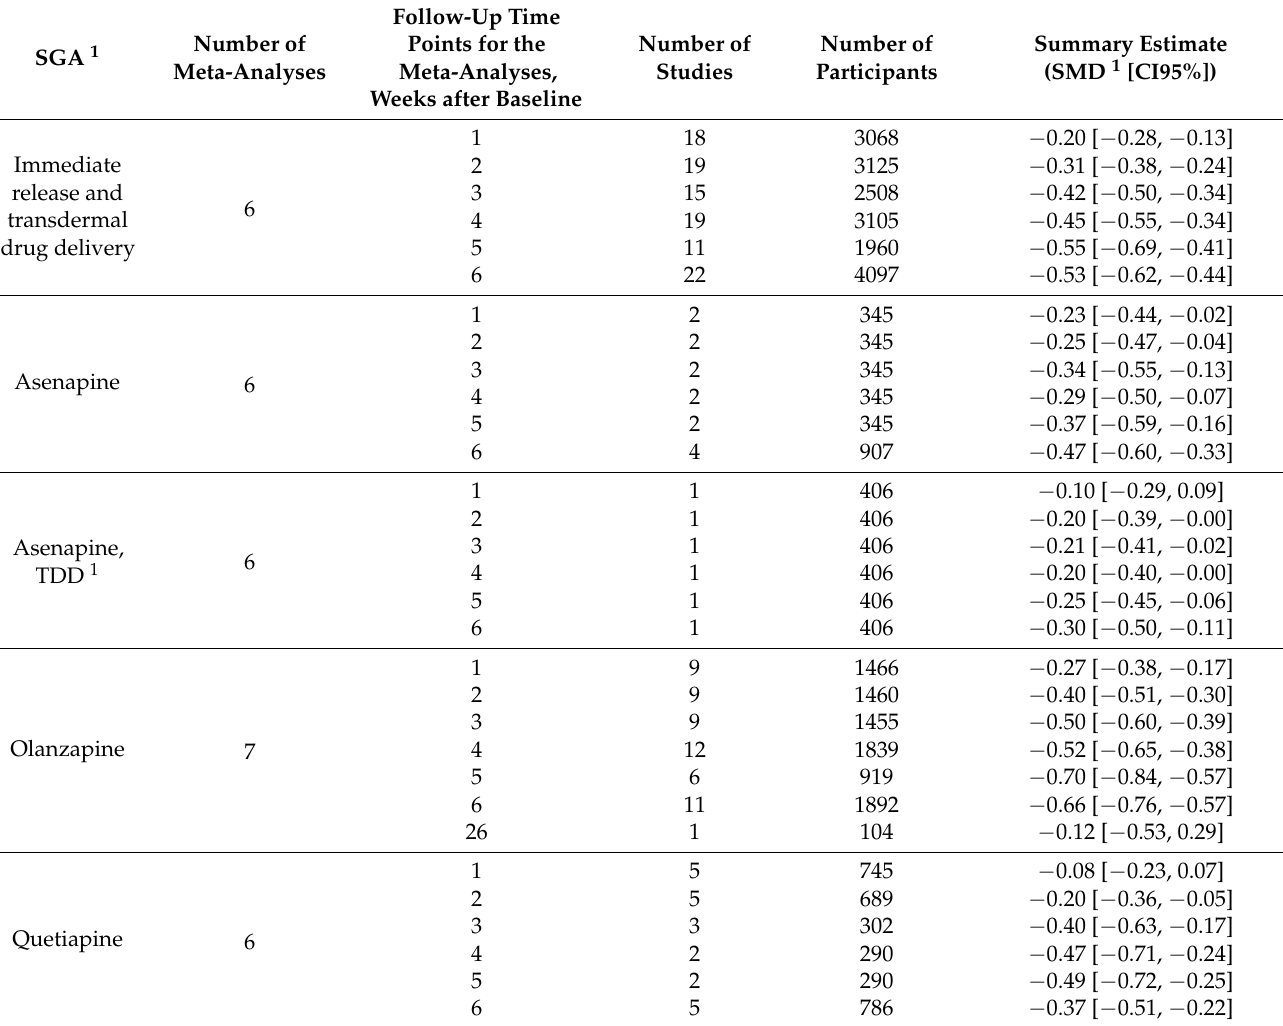
Table 1. Shows the number of meta-analyses made for each pine, and each of their follow-up time point with corresponding summary estimate (SMD